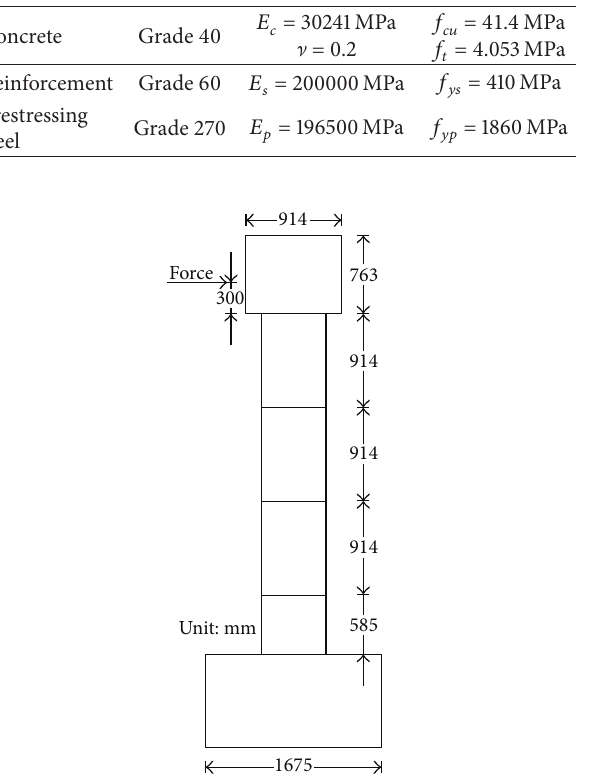
Table 1: Material properties.